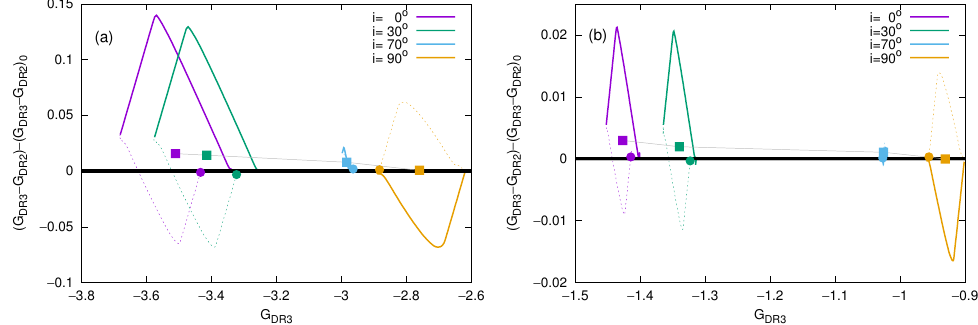
Figure 4. ( a ) Modeled (G DR 3 -G DR 2 ), normalized relative to the value at time zero, with subindex 0, versus G DR 3 for the B2 model. Different colors indicate different inclination angles. The dotted part of the curve corresponds to build-up and the continuous line to dissipation. The black line indicates the zero level (no variability). The full circles indicate the beginning of the cycle. The squares indicate the average value within a complete cycle and the gray line joins these squares. ( b ) Same as ( a ) for the B7